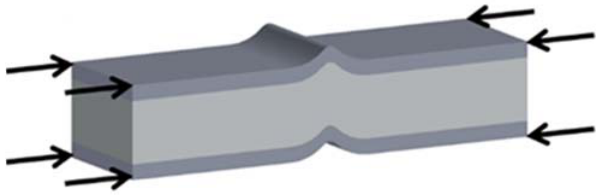
Figure 1. Honeycomb sandwich panel buckling failure mode, as reported in [33].